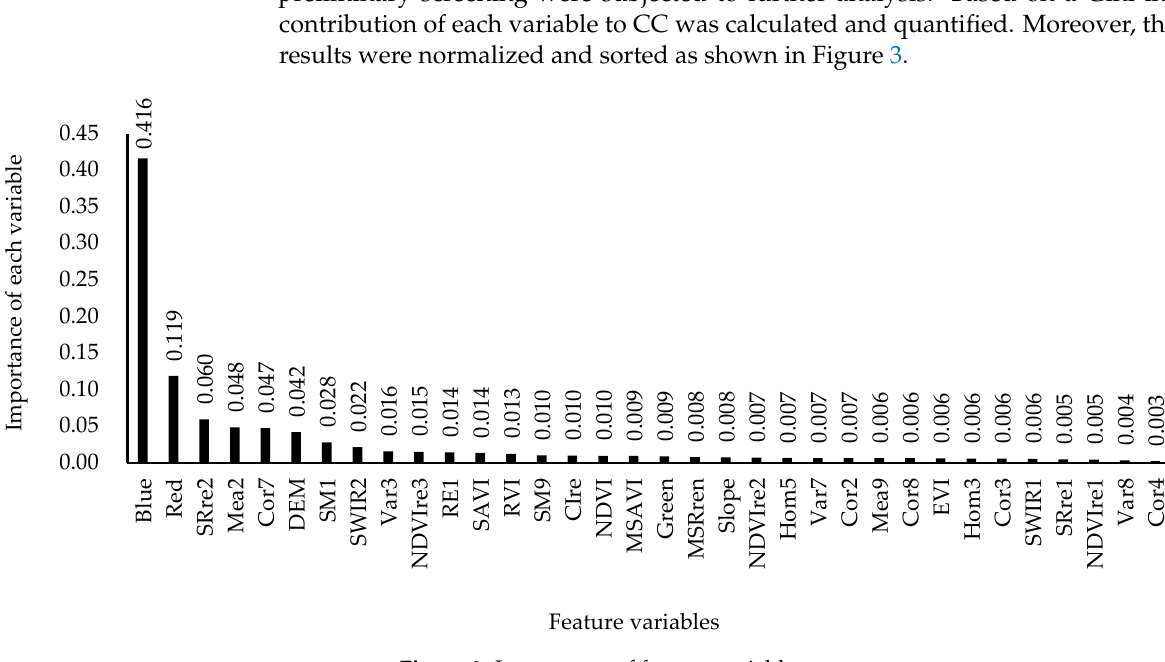
Figure 3. Importance of feature variables.